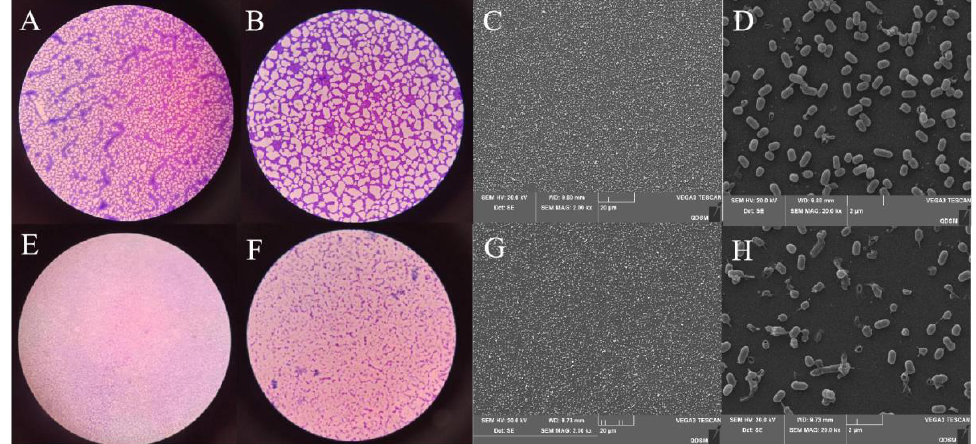
Figure 8. Effect of plantaricin Q7 on L. monocytogenes biofilm reduction. Optical microscope ( A , B , E , F ) and scanning electron microscope ( C , D , G , H ) images. Control group ( A – D ), treatment group ( E – H ). 40× magnification ( A , E ), 100× magnification oil lens ( B , F ), 2000× magnification ( C , G ), 20,000× magnification ( D , H ).